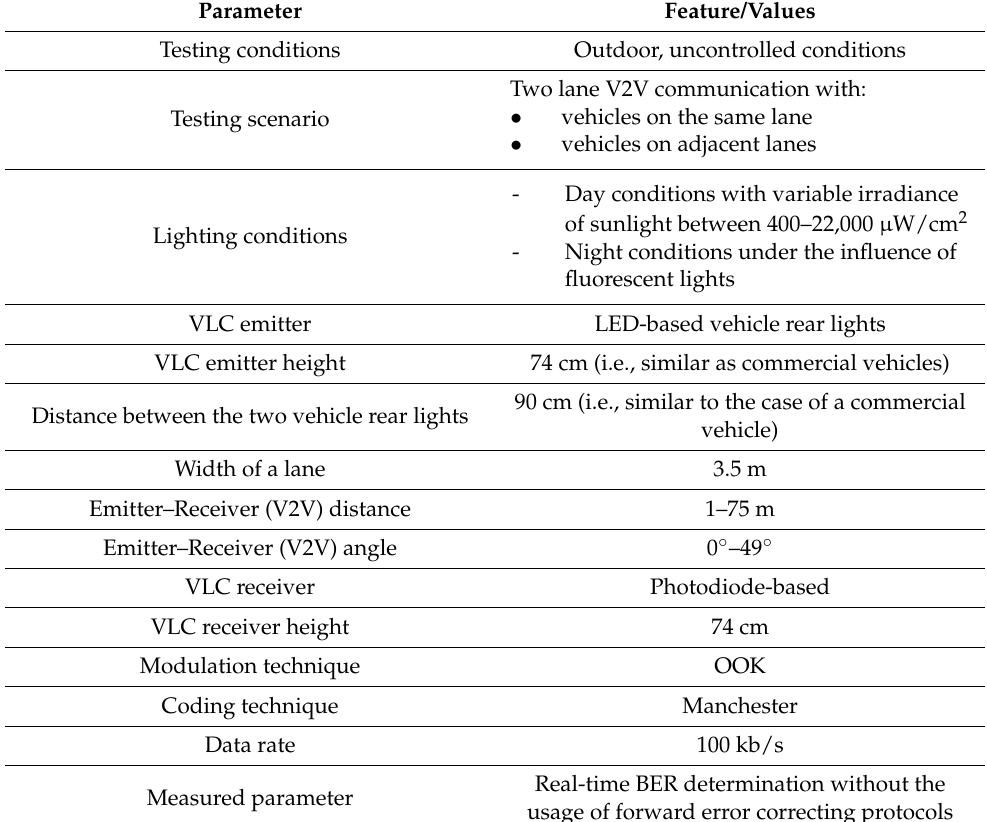
Table 3. Summary of the experimental